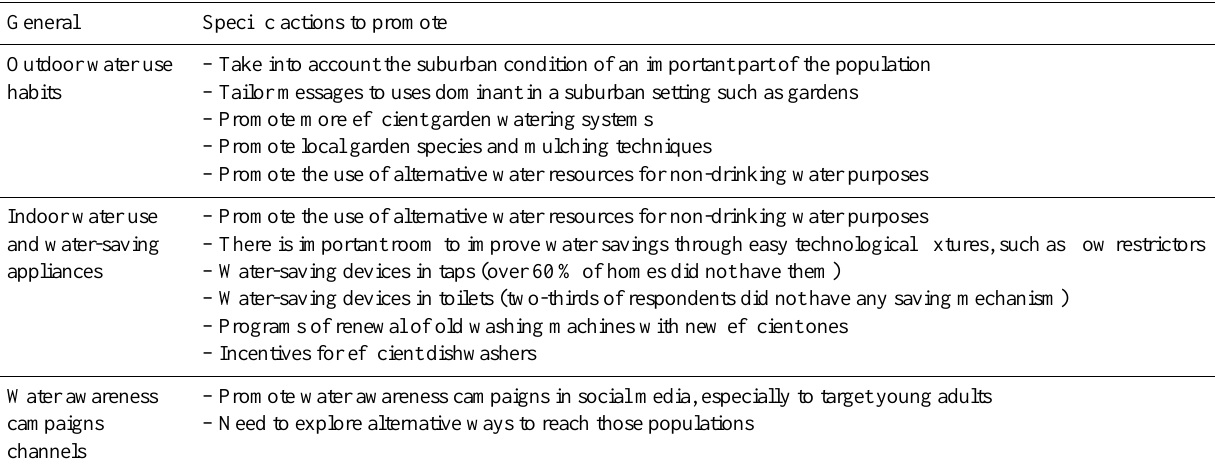
Table 4. Recommendations for Alicante for future water awareness campaigns.